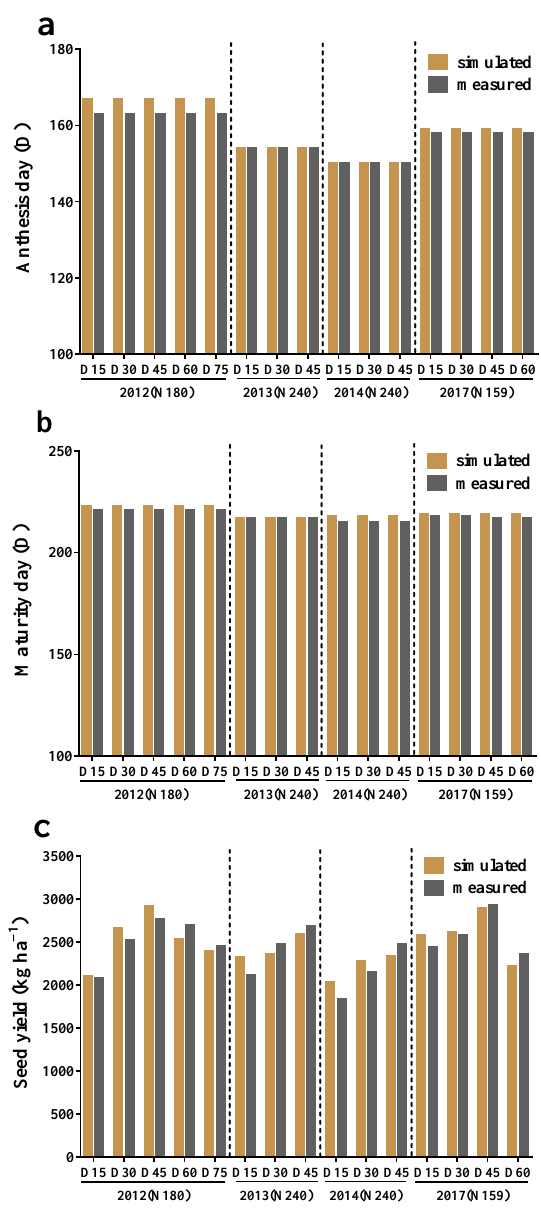
Figure 5. Measured and simulated anthesis day ( a ), maturity day ( b ) and yield ( c ) of Huayouza62 under different planting densities.